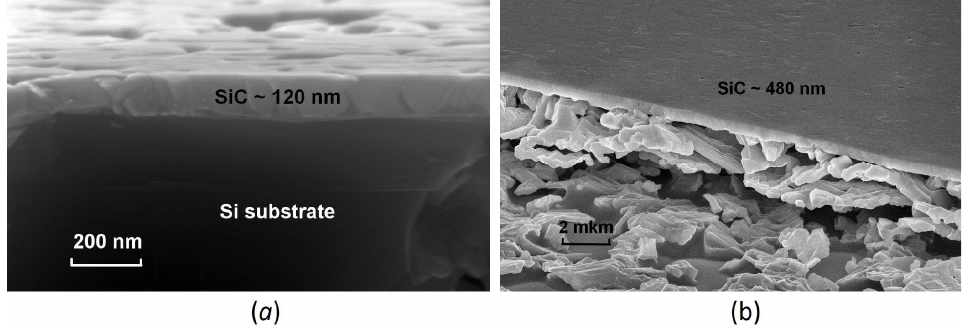
Figure 3. SEM images of 3C–SiC samples containing silicon vacancies grown on Si of n-type ( a ) and p-type ( b ).